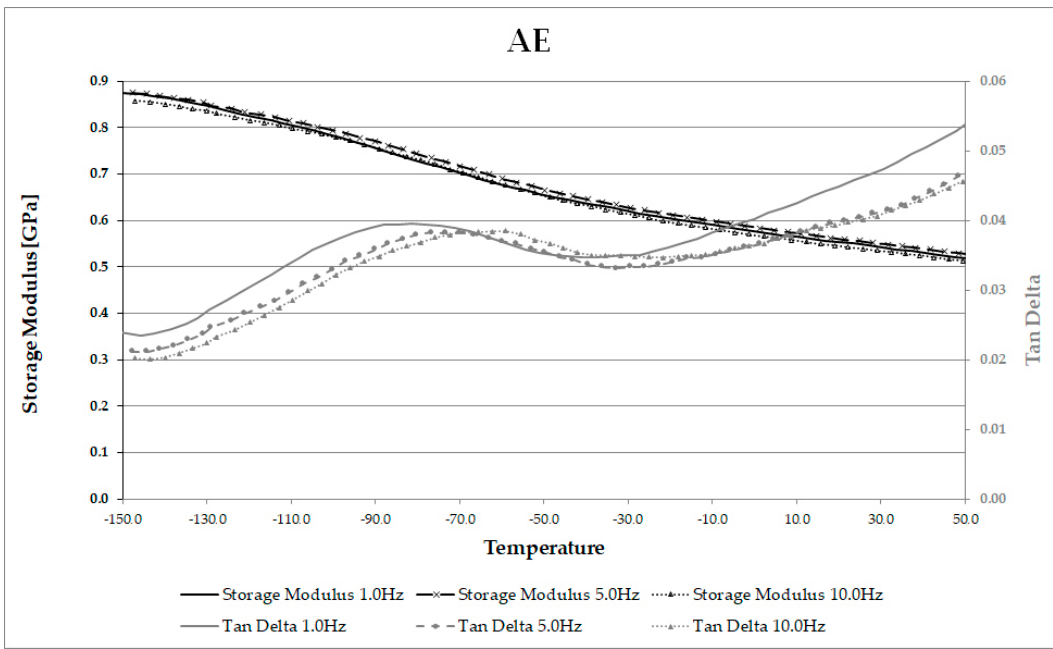
Figure 8. Multi-frequency scan of AE showing storage modulus and tan δ (note γ peak present at low temperatures).